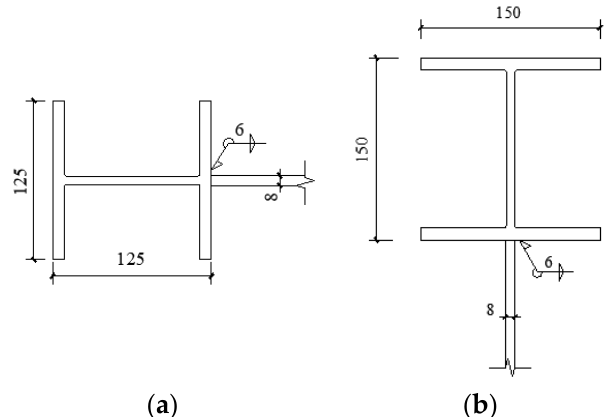
Figure 3. Detailed drawing of 30 mm thick small bottom plate (units: mm).